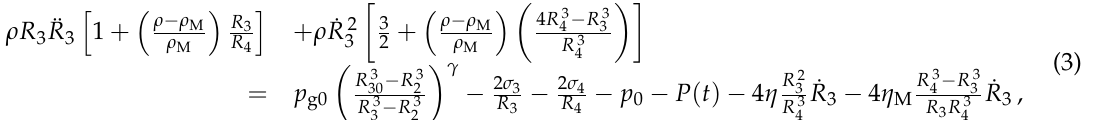
− R ) , separated by a gaseous void of 2 1